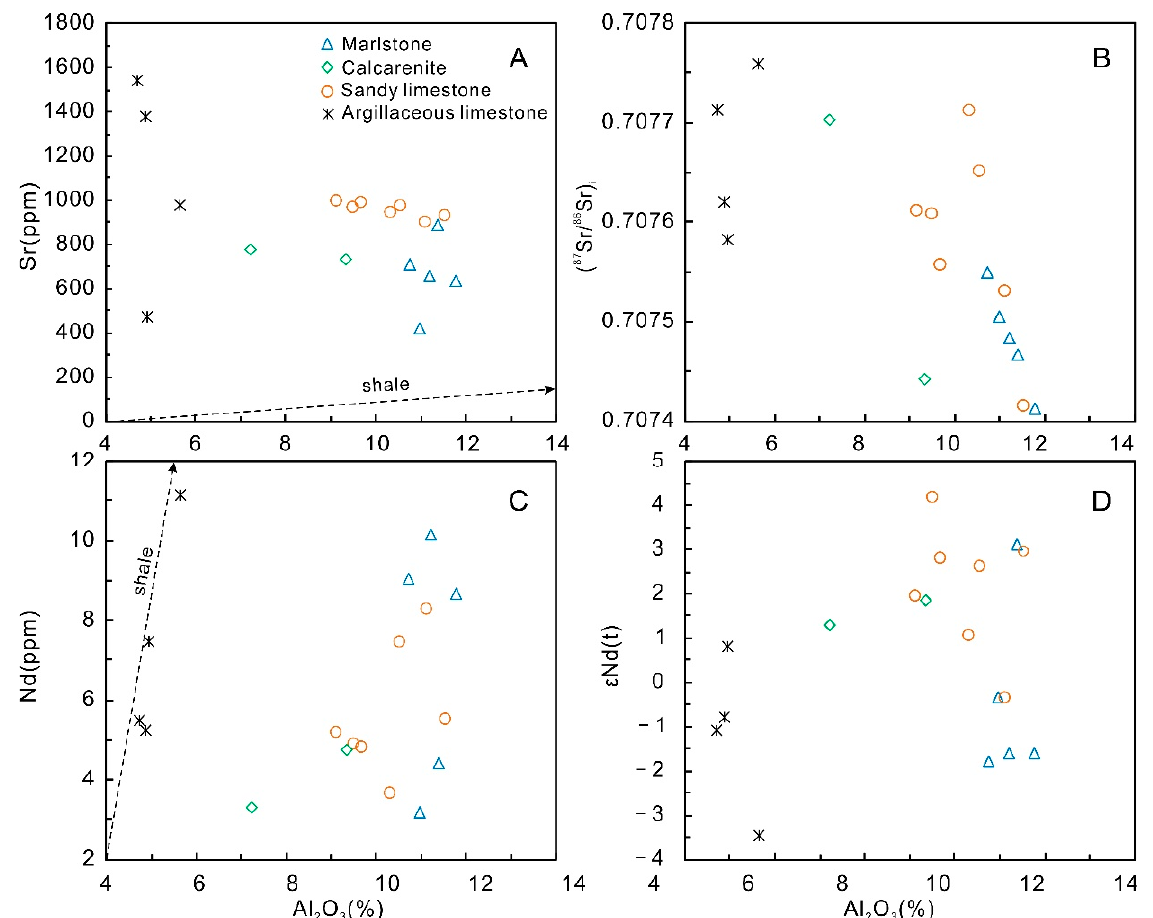
Figure 6. Cross-plots of Al 2 O 3 vs. ( A ) Sr content, ( B ) ( 87 Sr/ 86 Sr) i , ( C ) Nd content, and ( D ) ε Nd(t) for the associated wall rocks of the Ortokarnash manganese ore deposit. the associated wall rocks of the Ortokarnash manganese ore